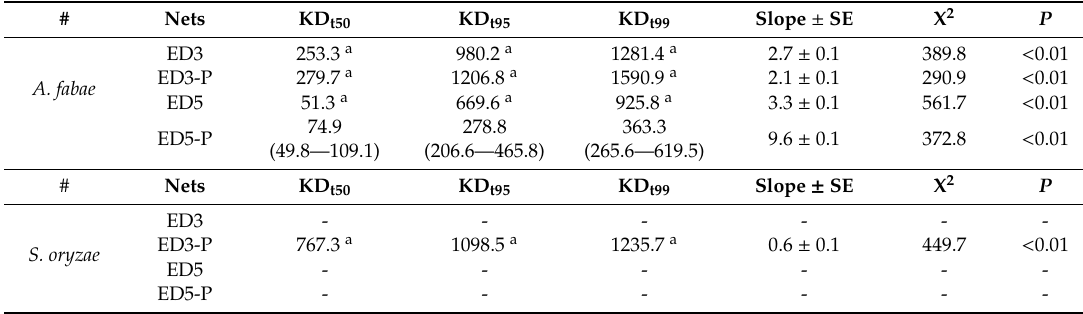
Table 2. Probit analysis for KD t50 , KD t95 , and KD T99 (confidence intervals) of Aphis fabae and Sitophilus oryzae adults exposed to four di ff erent nets (ED3, ED3-P, ED5, ED5-P) for 180 min, values are expressed as minutes to